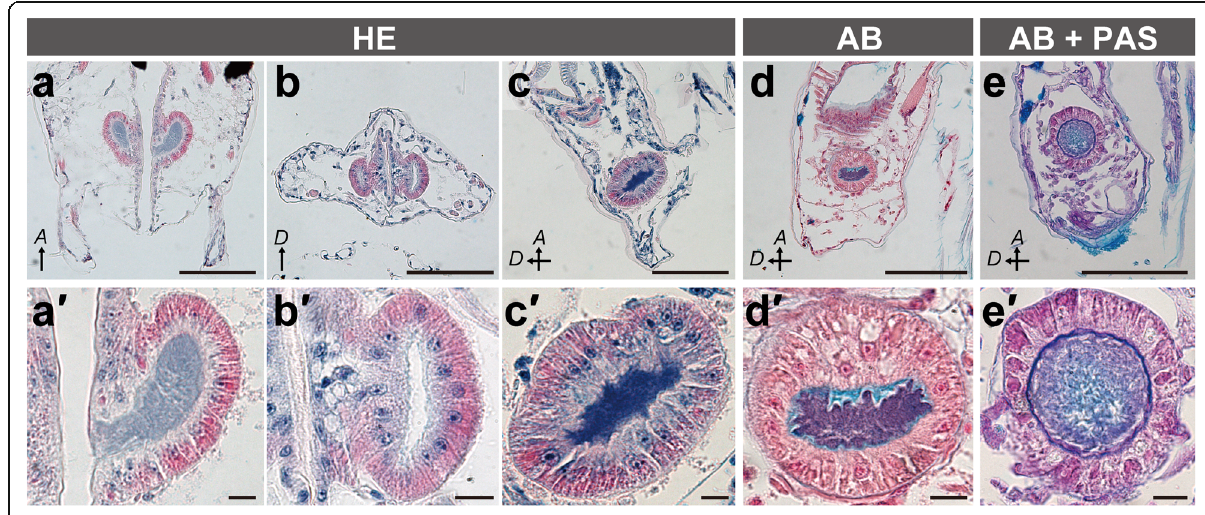
Fig. 3 Histological sections of the acinar glands in the pleotelson of P. algicola . a – c HE staining of horizontal (a), cross (b), and sagittal (c) sections. d AB and Kernechtrot staining, sagittal section. e AB and PAS staining, sagittal section. a ′ – e ′ Enlargements of glands from a – e , respectively. Abbreviations: A , anterior; D , dorsal. Scale bars: 100 μ m ( a – e ); 10 μ m ( a ′ – e ′